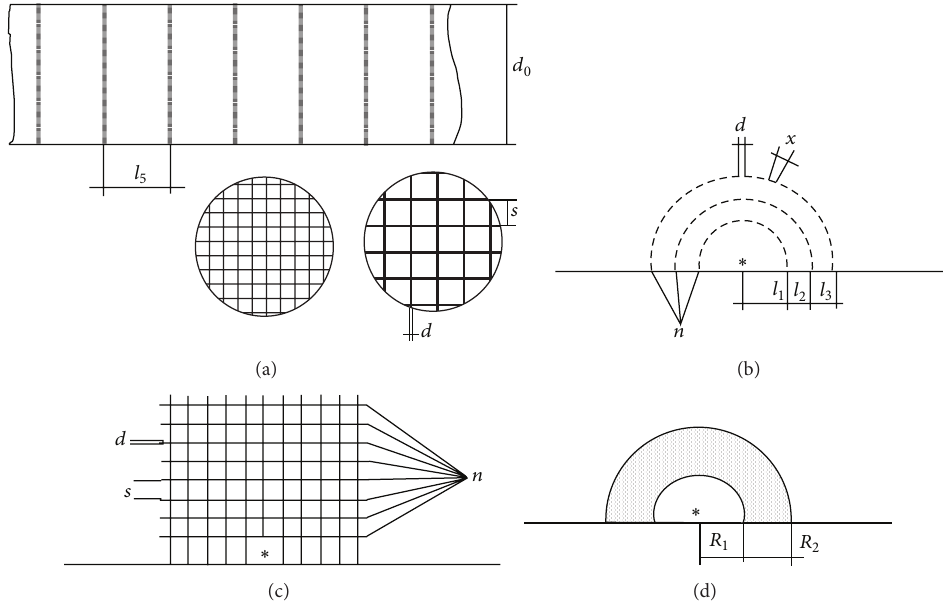
Figure24:Typicalschemaofuseofpassiveelementsforaccelerationof“plane”anddivergentflames:wireorrodscreens(a)(thecharacteristic parameters are the diameter of the wire 𝑑 , the permeability 𝑠 of the screen, and the distance between the screens 𝑙 5 ); hemispherical shells with holes (b) (parameters are hole diameter 𝑑 and holes displacement 𝑥 , number of hemispheres 𝑛 , and their spatial arrangement 𝑙 1 , 𝑙 2 , 𝑙 3 ,... ); 3D rod-structures (c) (parameters are rod diameter 𝑑 and permeability 𝑠 , number of rods 𝑛 𝑖 (total and in the planes); obstacles from porous materials (d) (radii 𝑅 1 and 𝑅 2 , porosity, number of porous layers, . . . ), and so forth.